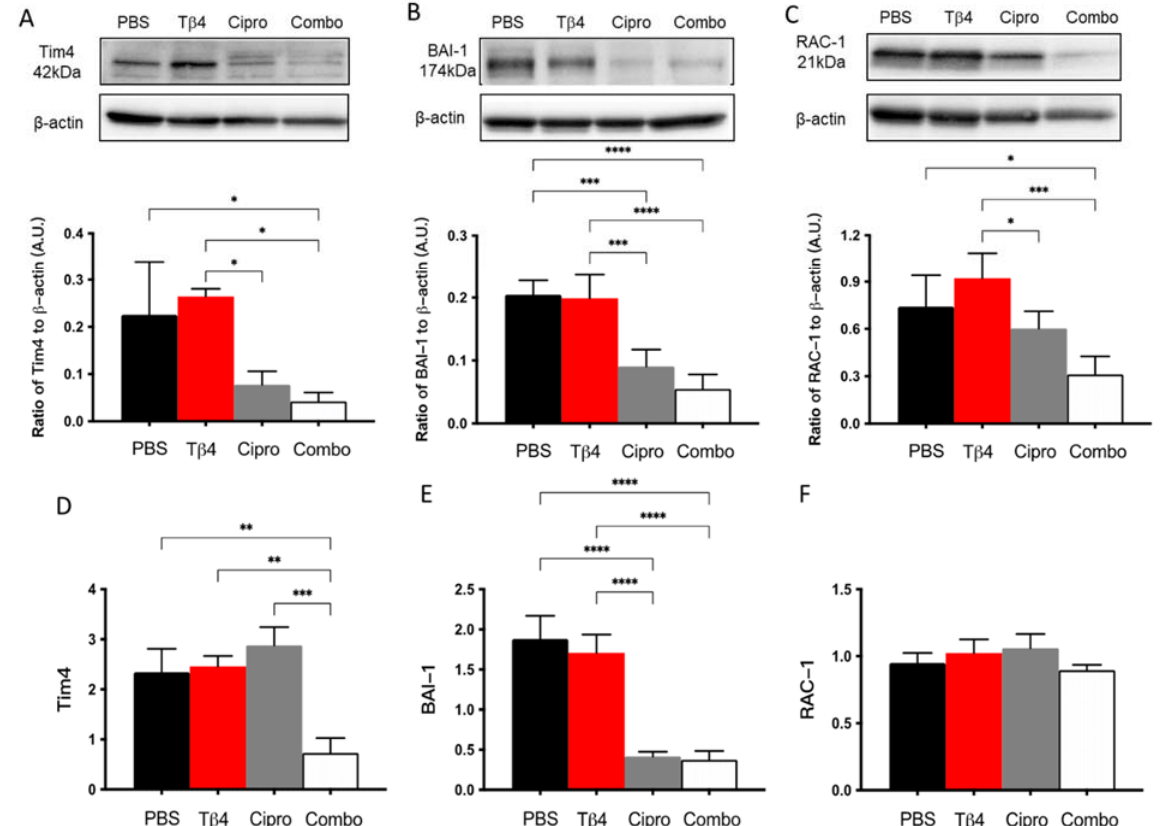
Figure 6. Efferocytosis activity was determined using select markers as detected at the protein level by Western blot ( A – C ) and mRNA level using real ‐ time RT ‐ PCR ( D – F ). Tim4 ( A , D ), BAI ‐ 1 ( B , E ), and RAC ‐ 1 ( C , F ) were assessed in corneas of PBS ‐ , T β 4 ‐ , cipro ‐ , and combo ‐ treated B6 mice at 3 days after infection. Western blot results are presented as a ratio normalized against β‐ actin ± SD. mRNA results are represented as a relative fold ‐ change for the gene of interest compared to normal (uninfected) controls ± SD. n = 3 corneas/group; * p < 0.05, ** p < 0.01, *** p < 0.001, **** p < 0.0001.